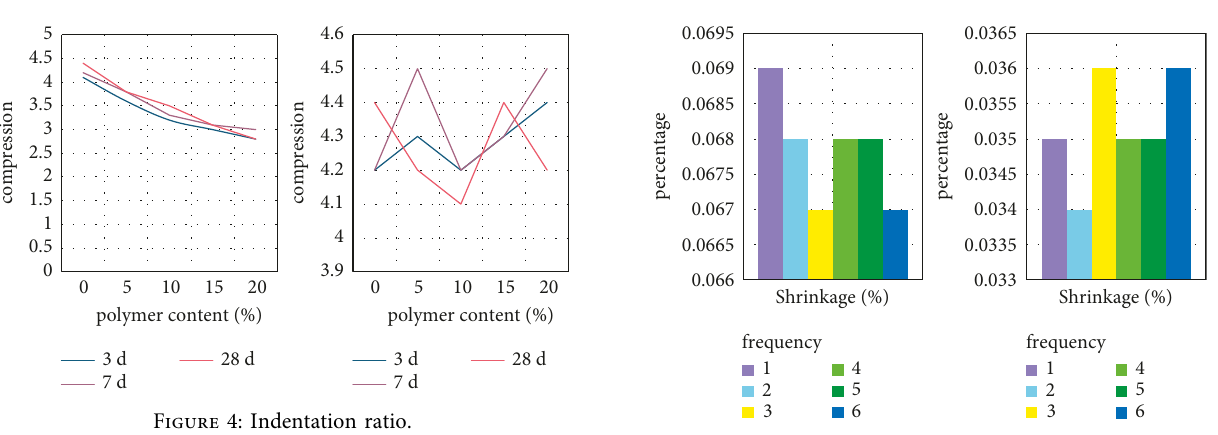
Figure 5: Shrinkage comparison.